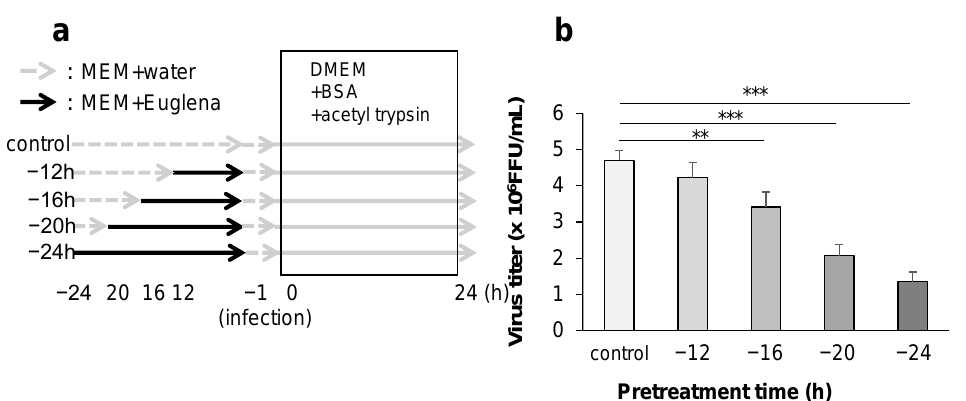
Figure 4. Inhibitory effect of pretreatment with Euglena extract on influenza virus growth. ( a ) Protocol. ( b ) Virus titer following the incubation of Madin–Darby canine kidney cells with Euglena extract for 12, 16, 20, and 24 h before viral infection. The cells were infected with the virus after the extract-containing medium had been replaced. The error bars indicate standard deviations ( n = 3); ** p < 0.01, *** p < 0.001. FFU: focus-forming units.